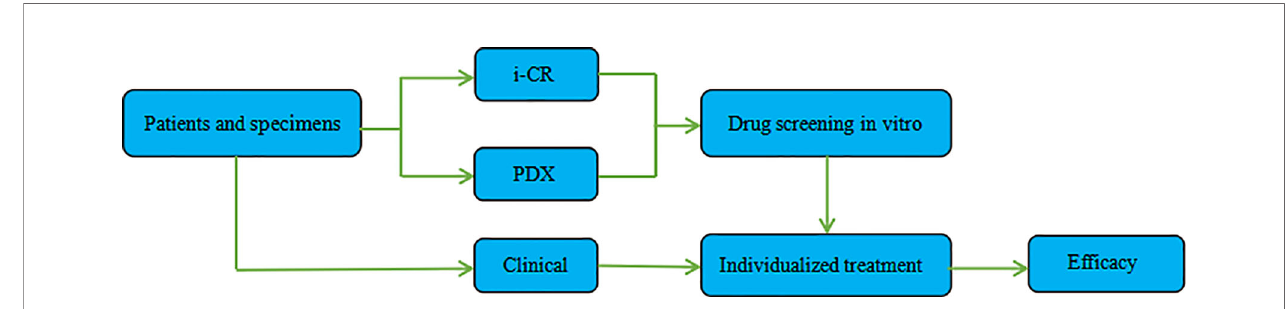
FIGURE 1 | Speci fi c method and fl ow chart of the i-CR system and PDX